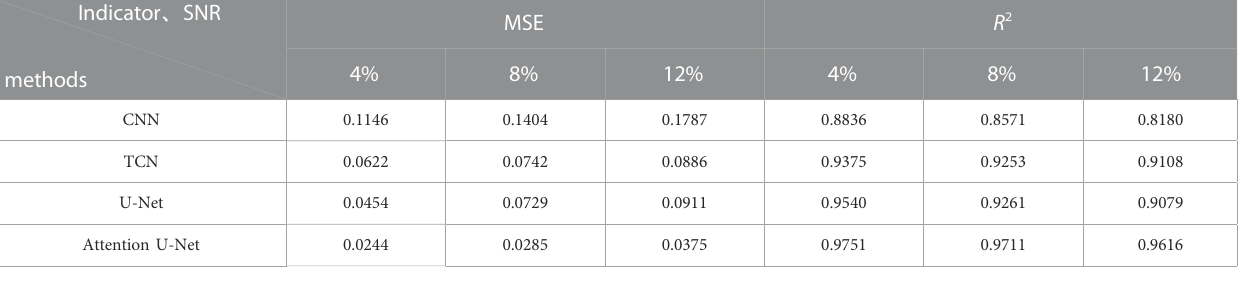
TABLE 2 MSE, R 2 between inversion results and actual acoustic impedance under different noise conditions.